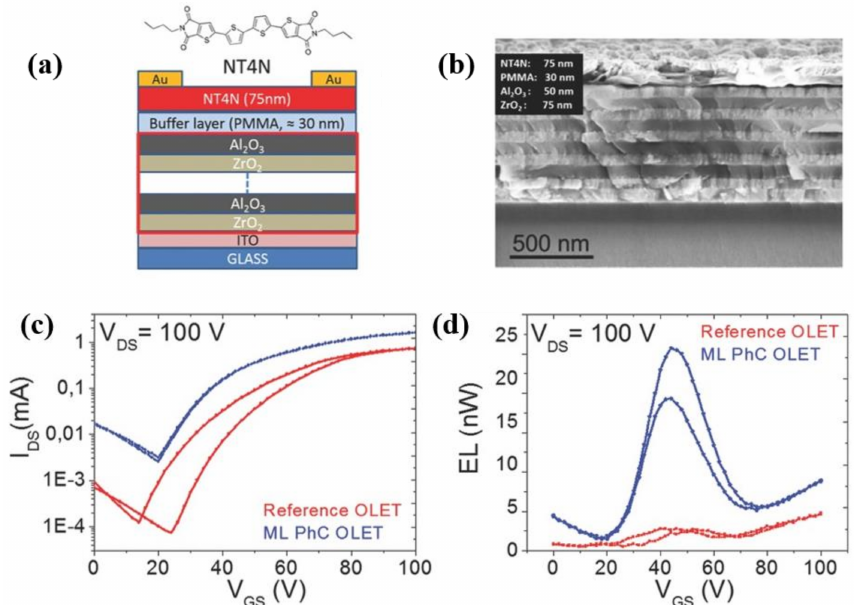
Figure 11. Photonic-crystal as dielectric layer in organic light emitting transistor. ( a ) Simplified schematics of the photonic crystal integrated in the OLED structure, with ( b ) corresponding SEM image of the stack, where alternating ZrO 2 and Al 2 O 3 layers are reported. ( c ) n -type saturation transfer characteristic and ( d ) electroluminescence (through the substrate) showing a 6-fold increase in the emitted power. Reproduced from [126], © (2020) John Wiley and